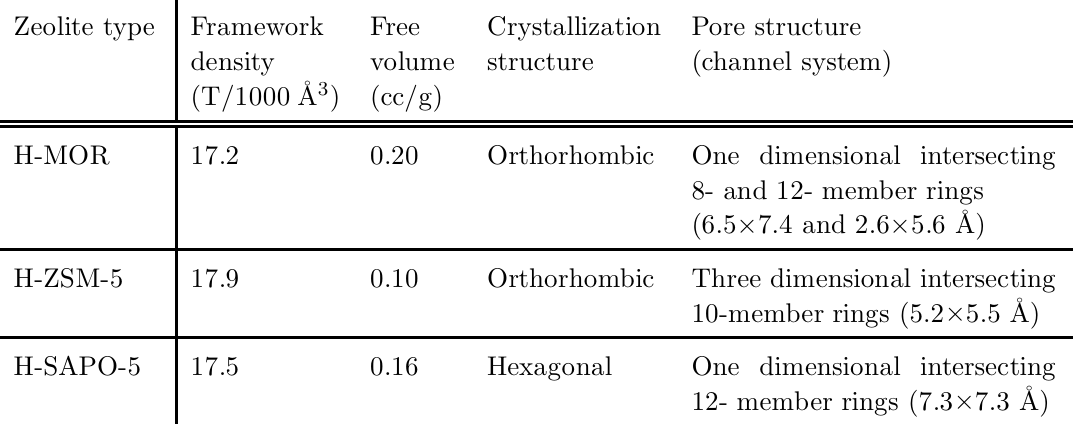
Table 1 Some crystalline network parameters of studied